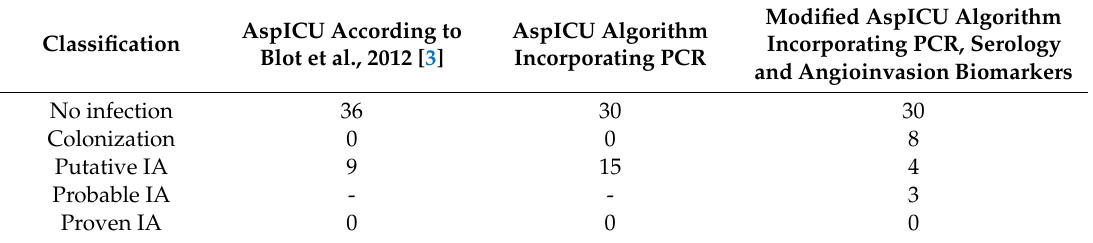
Table 2. Classification of 45 COVID-19 patients with ARDS according to AspICU and to modified AspICU